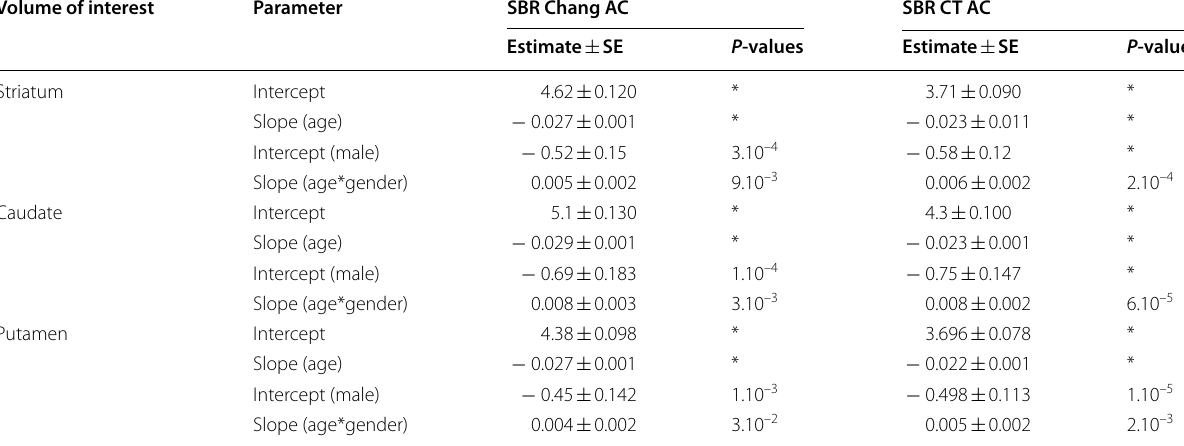
Table 3 Estimates of the general linear model analysis of SBR from the database ScanOnlyDB Volume of